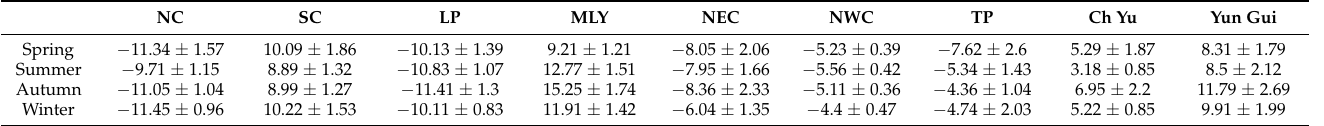
Figure 3. The changing trend of regional groundwater storage. ( a ) Monthly scale changes in groundwater in nine regions over many years. ( b ) The annual changing trend of groundwater in China based on Sen Slope and Mann-Kendall nonparametric tests. We used the Sen slope method to calculate the 17-year trend of groundwater storage grid by grid, and then we used the Mann-Kendall nonparametric test to verify whether the trend of change passed the 95% confidence test. The no significance test in Figure 3b indicates that these areas did not pass the 95% confidence level test. Significantly decreased areas had a changing rate of groundwater storage between − 71.08 mm y − 1 and − 27 mm y − 1 . Slightly decreased areas had a changing rate between − 27 mm y − 1 and − 9.46 mm y − 1 . The areas with no significant change had a changing rate between − 9.46 mm y − 1 and − 0.87 mm y − 1 . Slightly increased areas had a change rate between − 0.87 mm y − 1 and 7.89 mm y − 1 . Significantly increased areas had a changing rate between 7.89 mm y − 1 and 18.9 mm y − 1 . Table 1. Seasonal changing rate of groundwater storage in nine regions (mm y − 1